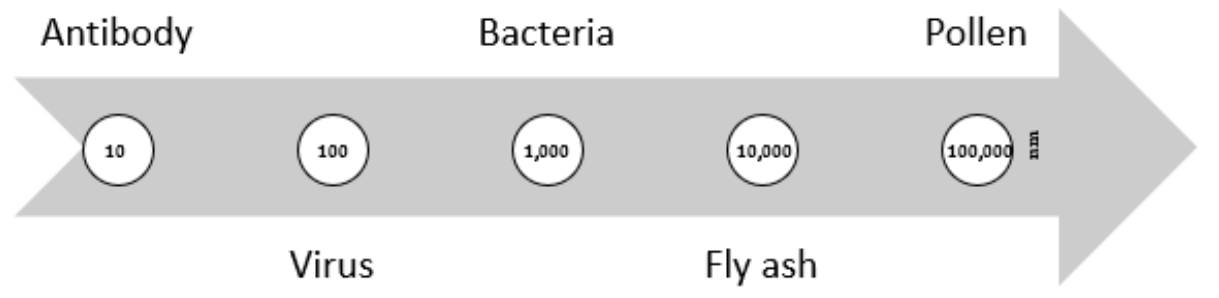
Figure 1. Different particle sizes to be filtered.